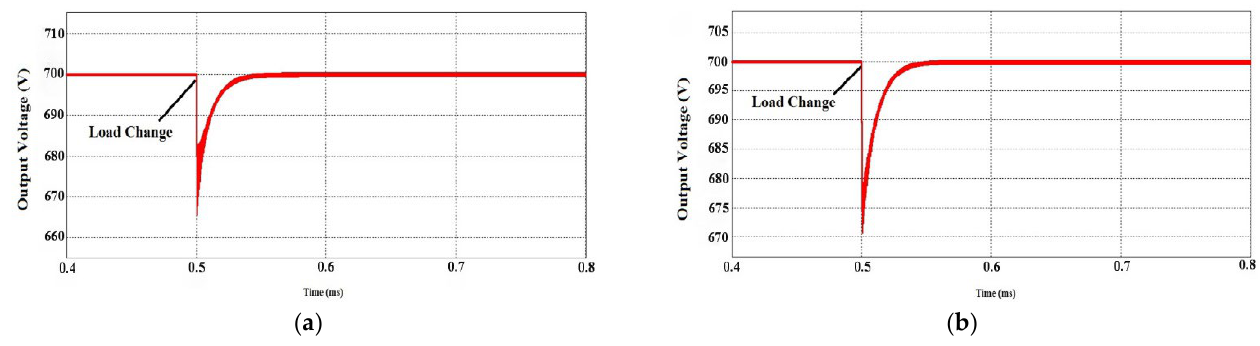
Figure 7. Performance of the control circuit for a load exposed to an instantaneous change ( a ) 25% to 100% of rated load ( b ) 50% to 100% of rated load.